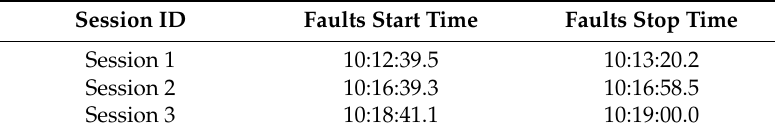
Table 2. Defined fault sessions and the time duration of the faults.